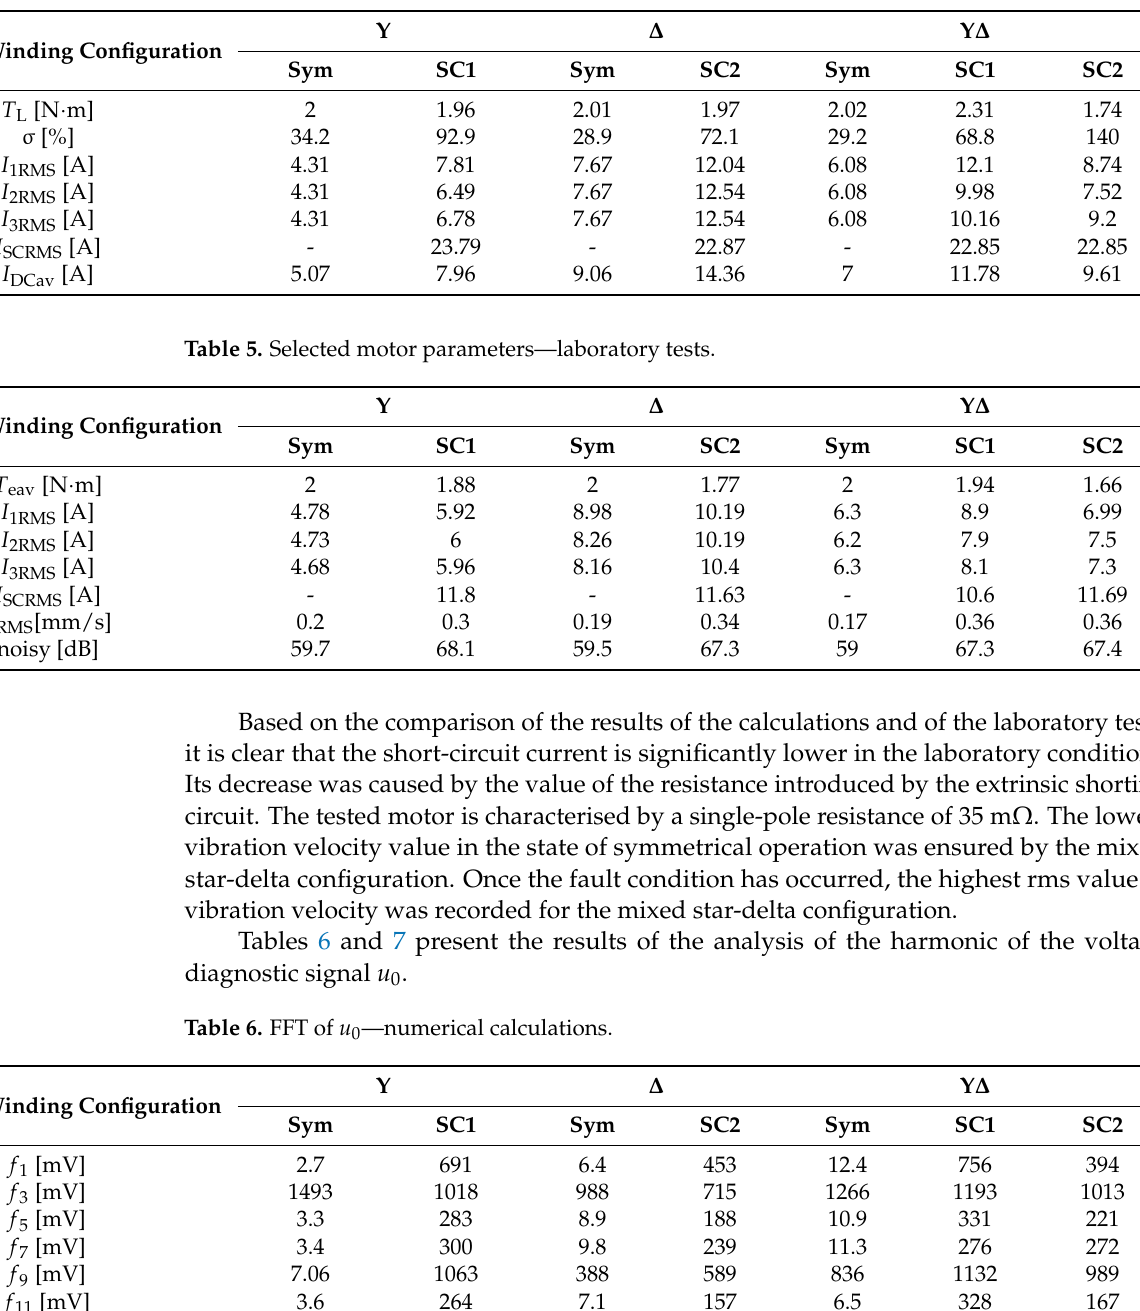
Table 4. Selected motor parameters—numerical calculations.